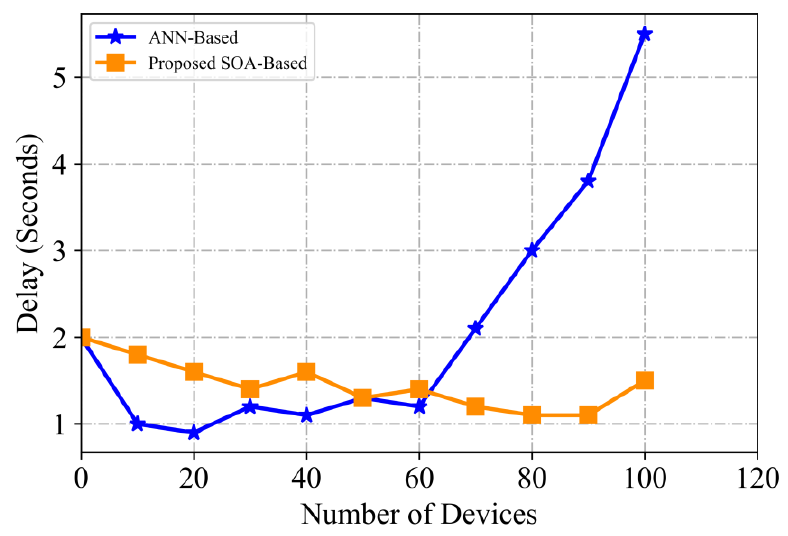
Figure 10. Comparative analysis of delay.